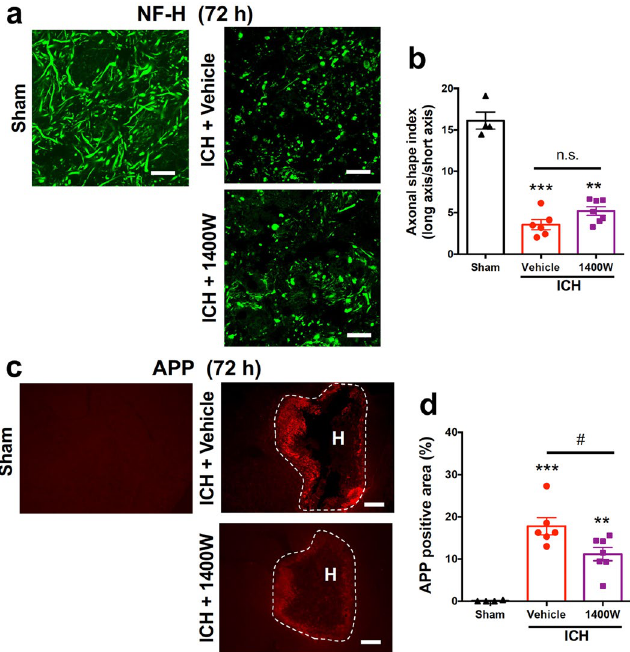
Figure 8. Effect of iNOS inhibitor on axonal integrity after ICH. 1400 W (20 mg/kg) or vehicle was intraperitoneally administered twice daily for six times from 3 h after ICH induction, and immunohistochemical examinations for NF-H and APP were conducted on coronal brain sections obtained at 72 h after ICH. ( a ) Representative images of NF-H-immunopositive axons in the internal capsule within the hematoma. Scale bars = 20 μm. ( b ) Quantitative results of the morphology of axonal fibers as axonal shape index. ( c ) Representative images of APP immunohistochemistry. Scale bars = 500 μm. H; hematoma. ( d ) Quantitative results of APP-positive area. Number of mice examined was 4 in sham group, 6 in ICH + vehicle group and 7 in ICH + 1400 W group, respectively. * P < 0.05, ** P < 0.01 versus sham group, # P < 0.05, n.s., not significant (ANOVA results: for b , F 2,14 = 85.88, P < 0.001; for d , F 2,14 = 23.16, P <